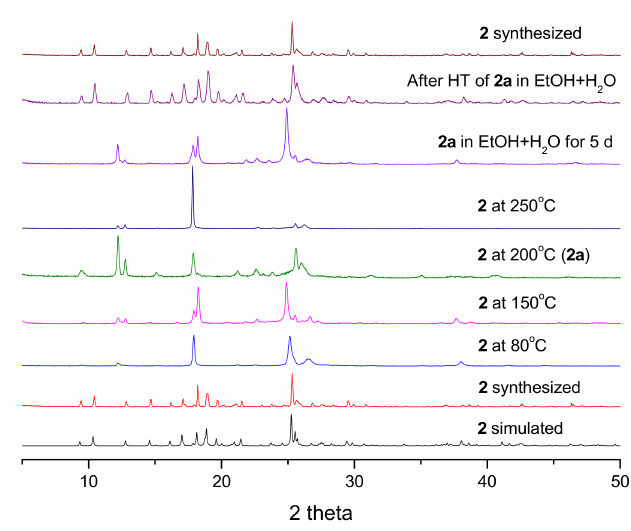
Figure 6. Variable temperature powder XRD patterns of 2 showing reversible structural transformation.